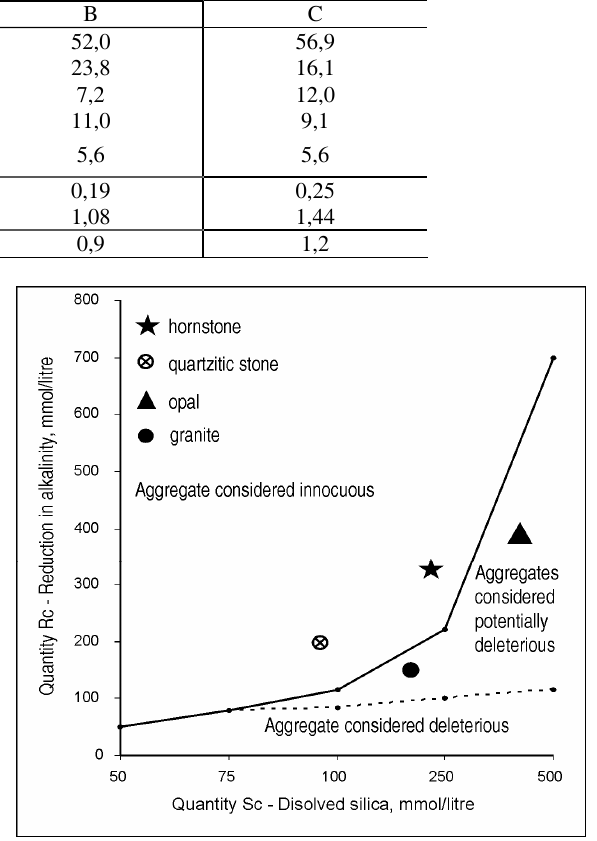
Fig 1. Illustration of division between innocuous and po- tentially deleterious aggregates on the basis of reduction in alkalinity test (ASTM C 289)